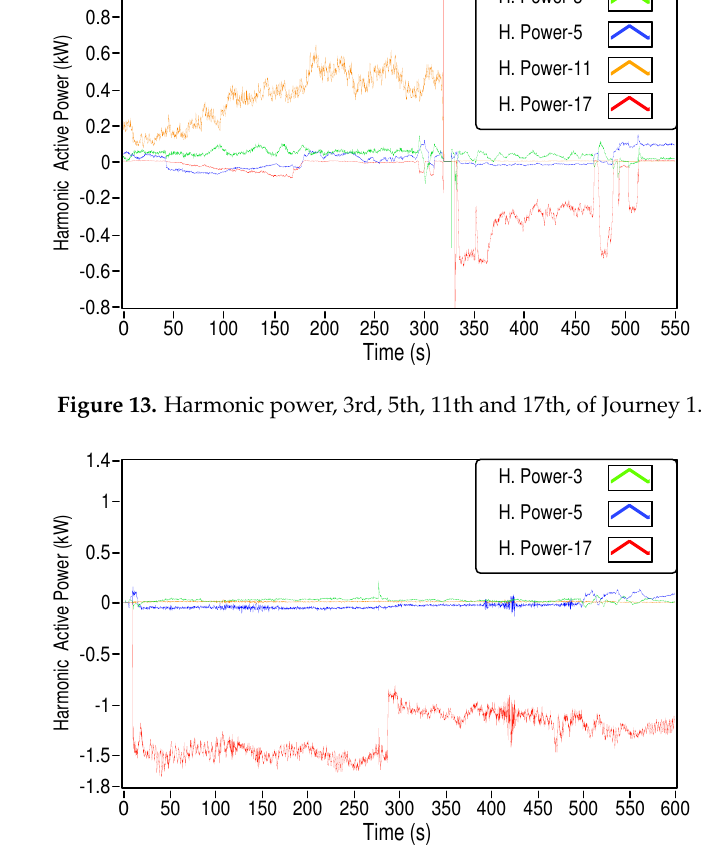
Figure 14. Harmonic power, 3rd, 5th, and 17th, of Journey